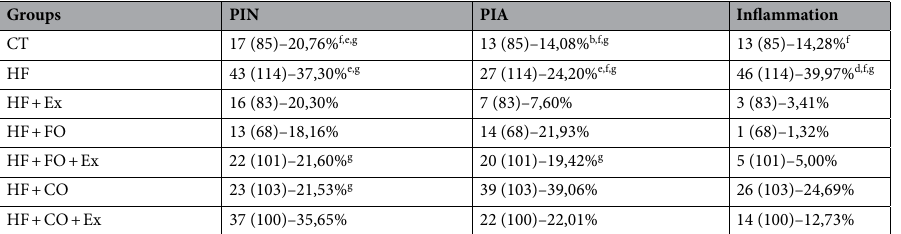
Table 2. Occurrence of histopathological data of experimental animals. CT Control Group, HF high-fat diet, HF + Ex high-fat diet and aerobic physical exercise, HF + FO high-fat diet and fish oil, HF + FO + Ex high-fat diet, fish oil and aerobic physical exercise, HF + CO high-fat diet and chia oil, HF + CO + Ex high-fat diet, chia oil and aerobic physical exercise. The results were expressed in absolute values and occurrence of percentages. The significative differences were adopted based on p < 0,05. Test